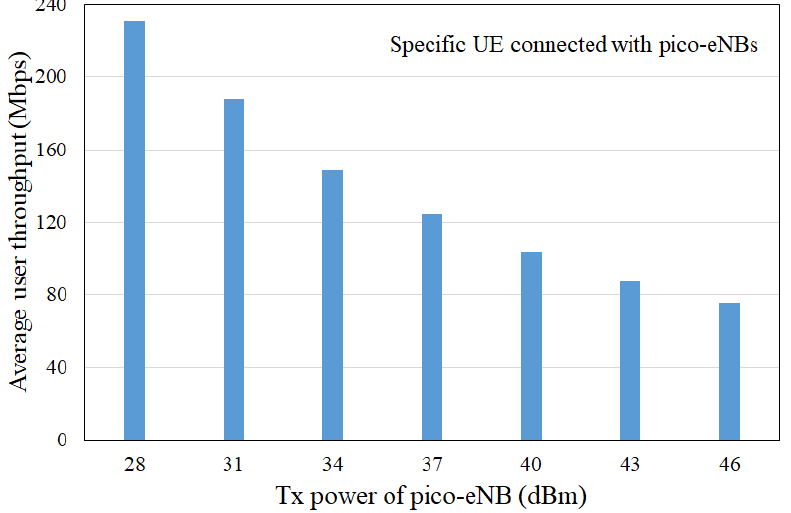
Figure 8. Average user throughput of specific UE connected with pico-eNBs as a function of pico-eNB Tx power.